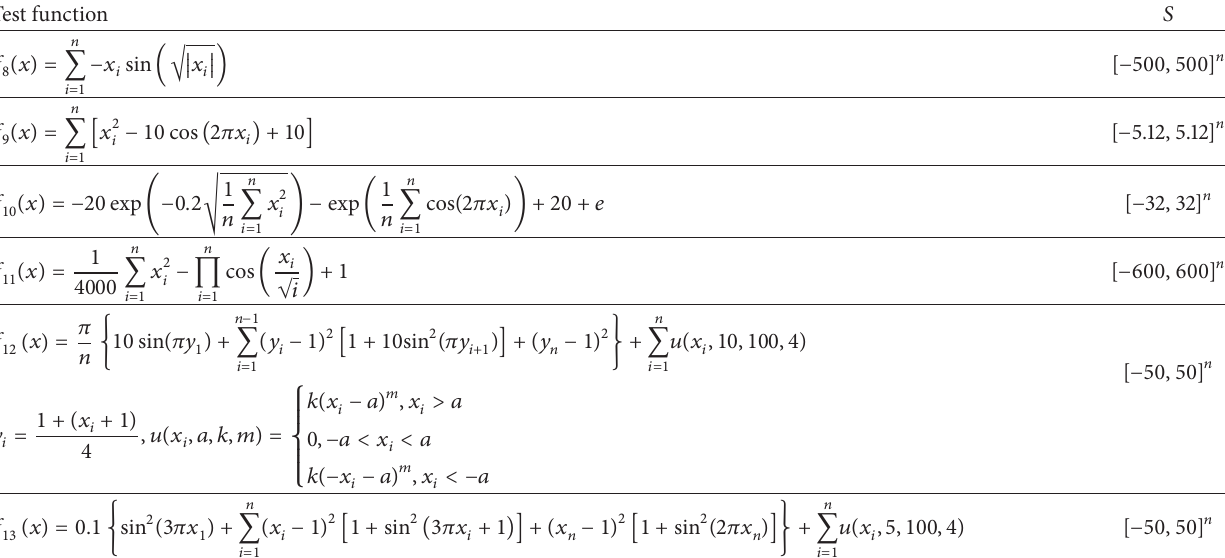
Table 2: Multimodal test functions.